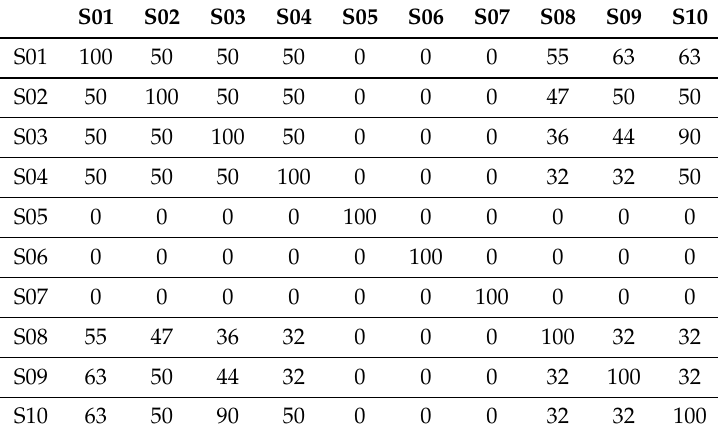
Table 25. Test results with ad-hoc signatures and